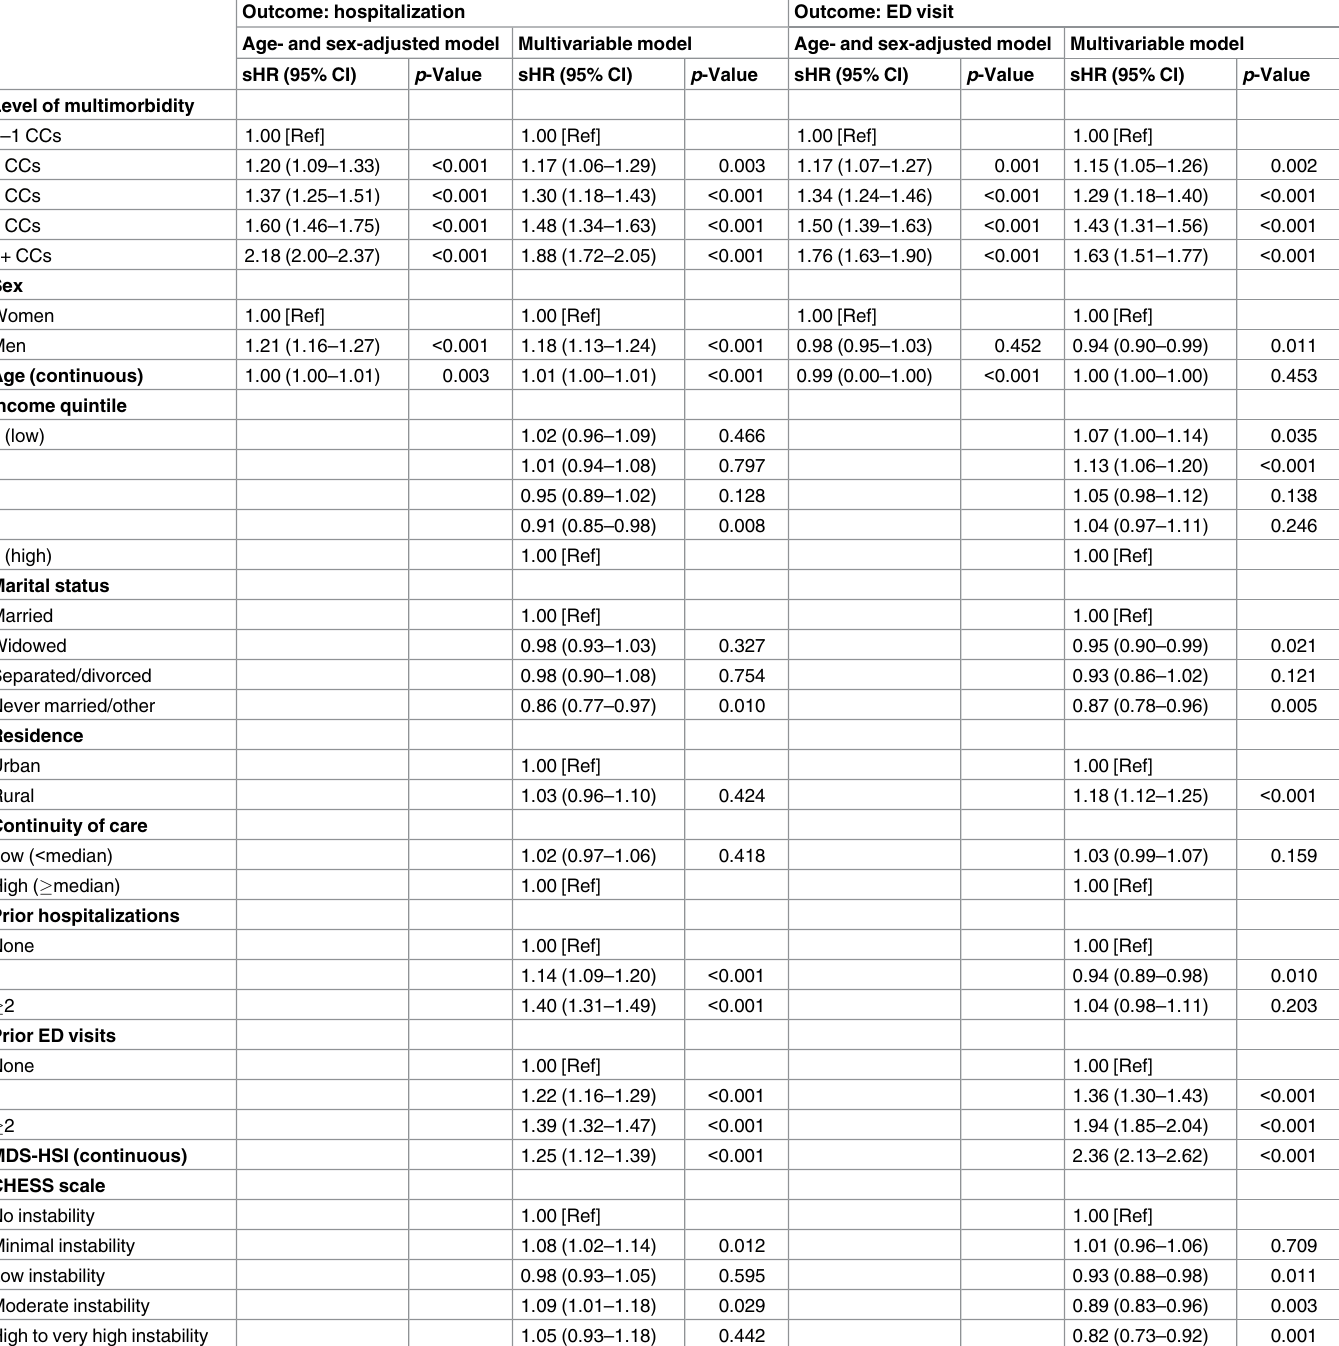
Table 3. Association between level of multimorbidity (number of diagnosed chronic conditions) and 1-y risk of acute hospitalization and emer- gency department visit among long-stay home care clients with dementia in Ontario in